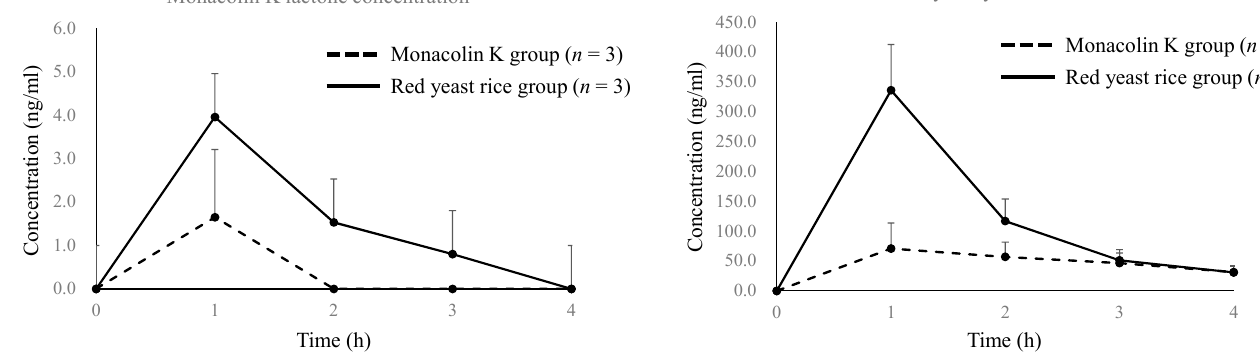
Figure 14. Plasma concentrations of lactone form and acid form of monacolin K after single administration of purified monacolin K or red yeast rice (40 mg/kg monacolin K or dose of red yeast rice equivalent to 40 mg/kg monacolin K) in male SD rats (7 weeks old). Each bar indicates the mean ± standard deviation, quantified according to the reference method [43]. Table 3. Pharmacokinetic parameters of the lactone form and acid form of monacolin K in plasma after single administra- tion of purified monacolin K or red yeast rice (40 mg/kg monacolin K or dose of red yeast rice equivalent to 40 mg/kg monacolin K). Peak analysis was performed according to the reference method [44].